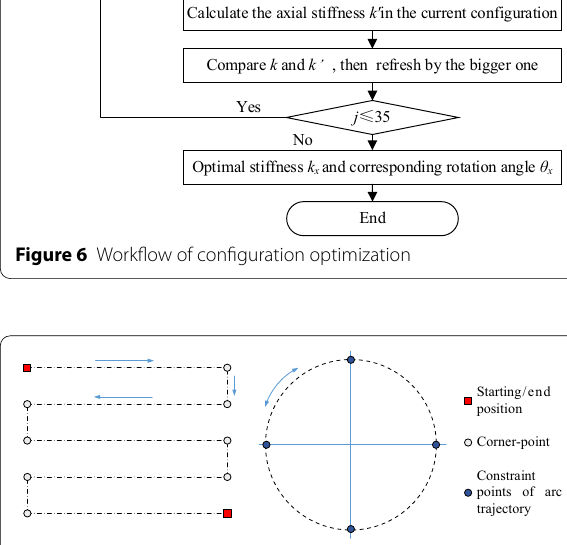
Figure 7 Several typical operation points